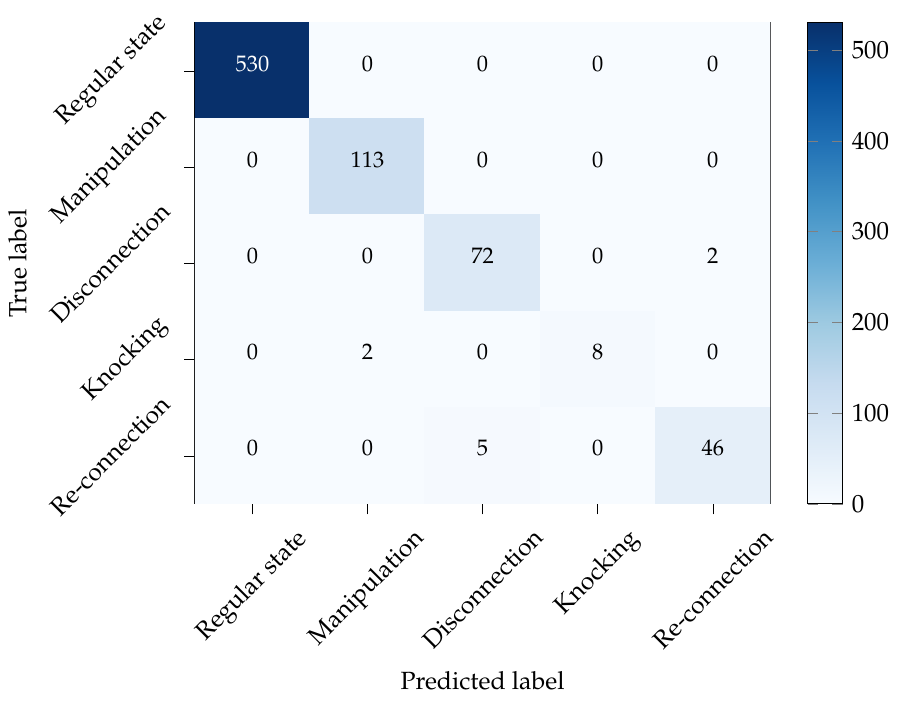
Figure 10. Confusion matrix evaluated on the testing dataset after learning, which shows the true performance of the proposed event classification